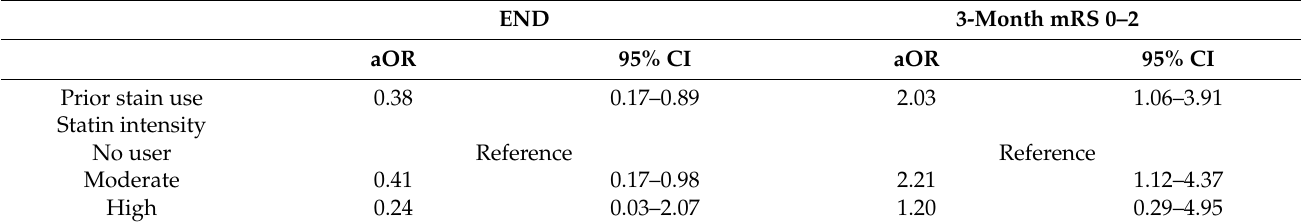
Table 3. Multivariate analysis showing effect of prior statin use on stroke